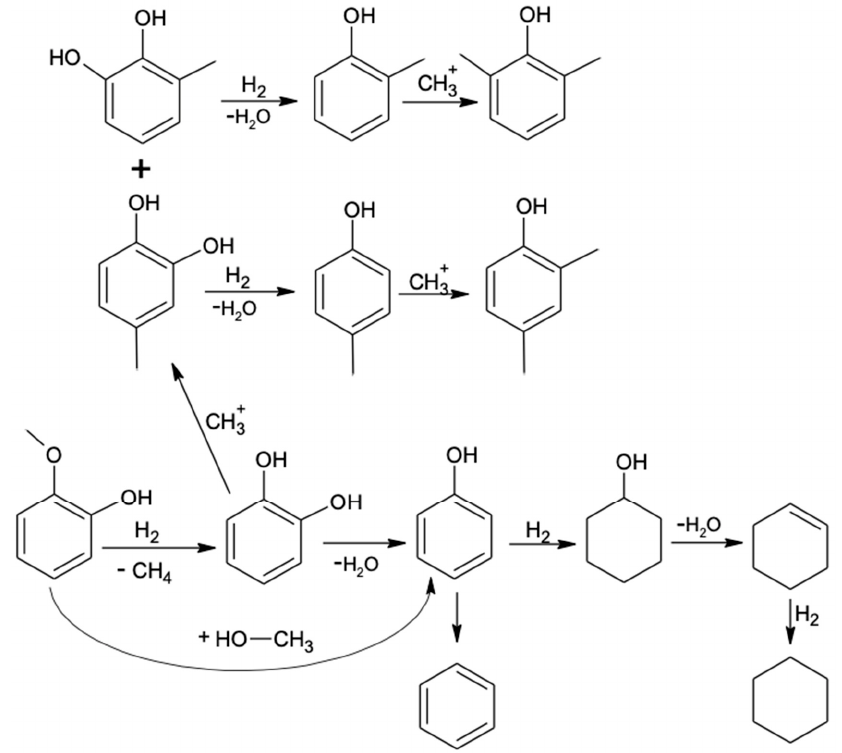
Figure 9. The reaction mechanism for the HDO of guaiacol. Reproduced from reference [83].